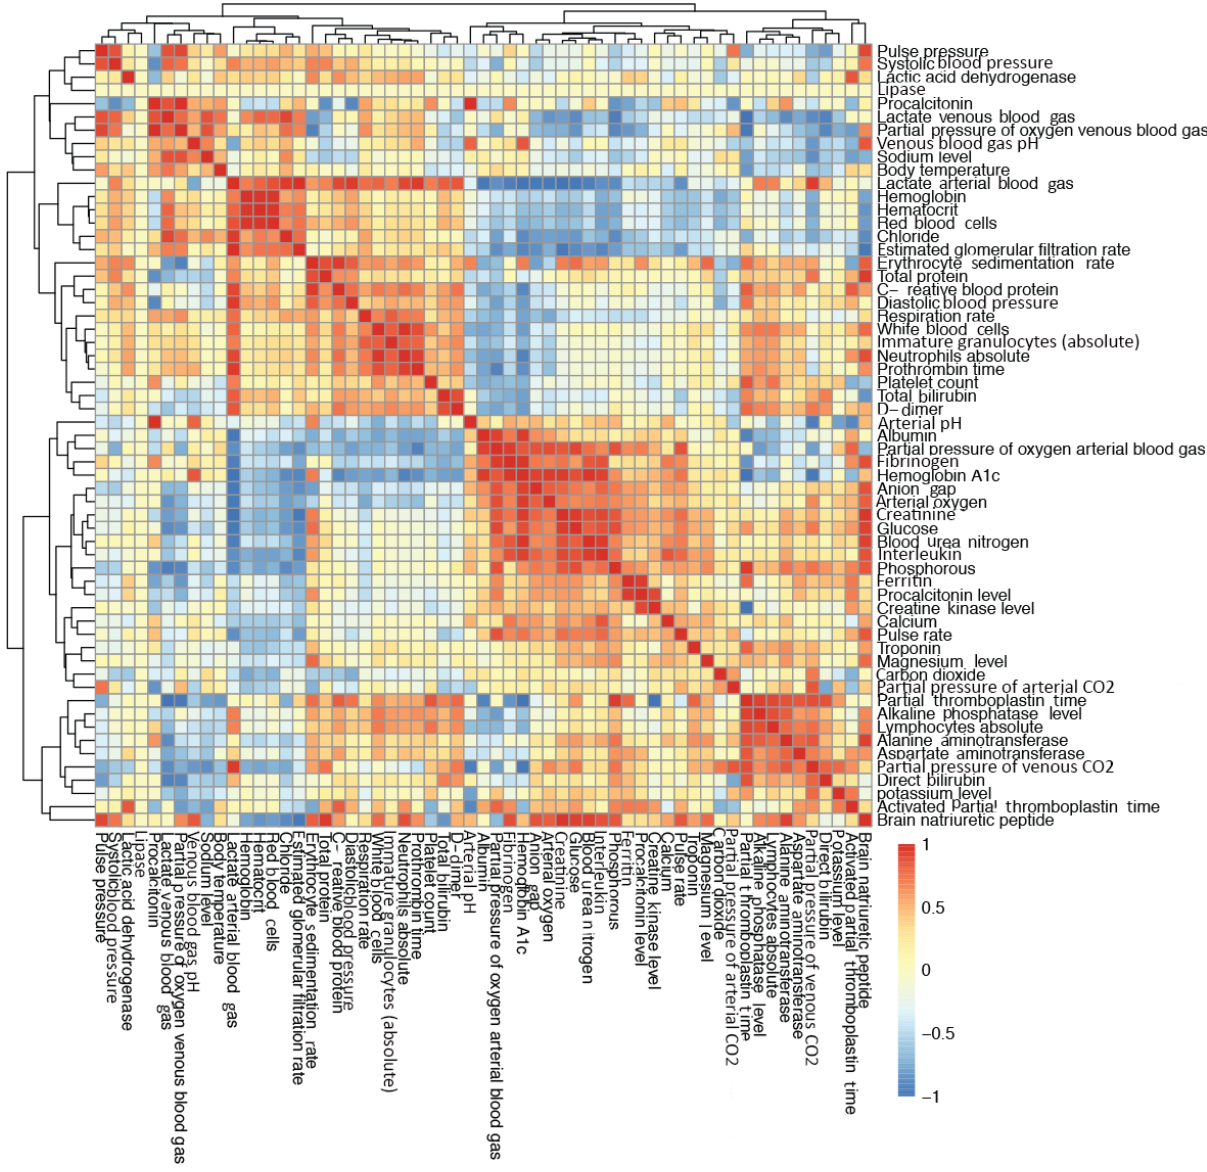
Figure 5. Correlation heat map among the various blood parameters examined using the data set of 89 patients. D-dimer: dimerized plasmin fragment